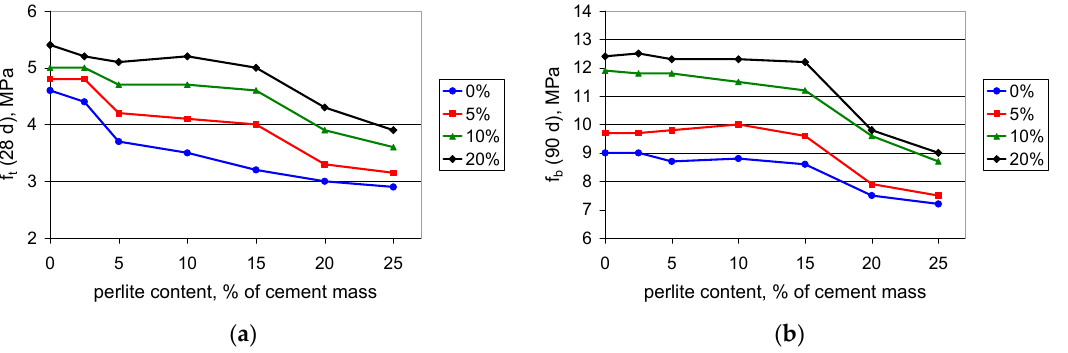
Figure 5. Tensile strength of mortars with polymer content values of 0%, 5%, 10%, and 20% of cement mass vs. waste perlite content: ( a ) after 28 days; ( b ) after 90 days of curing.